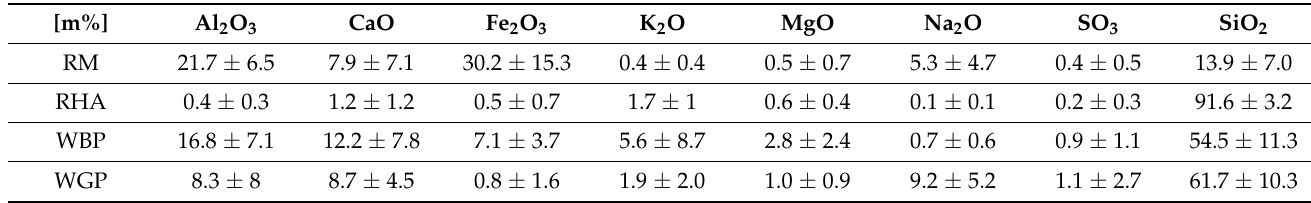
Table 2. Chemical compositions of alternative